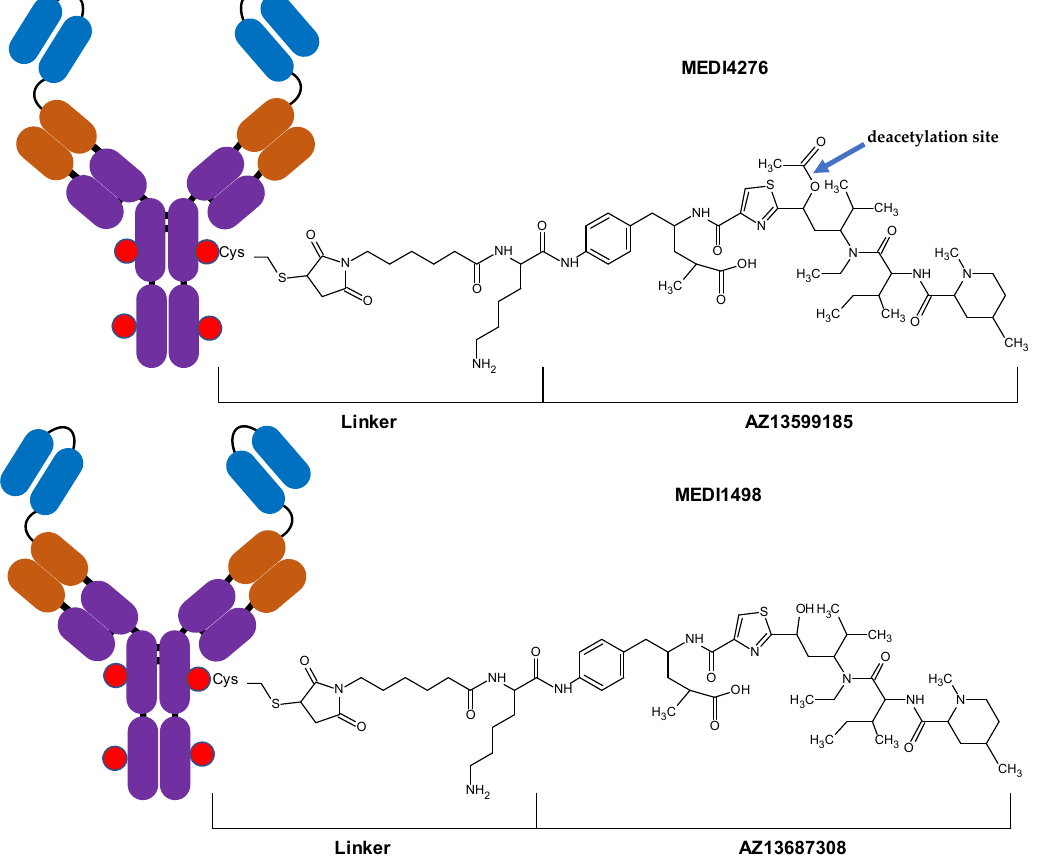
Figure 1. Diagrams of antibody-drug conjugates MEDI4276 and